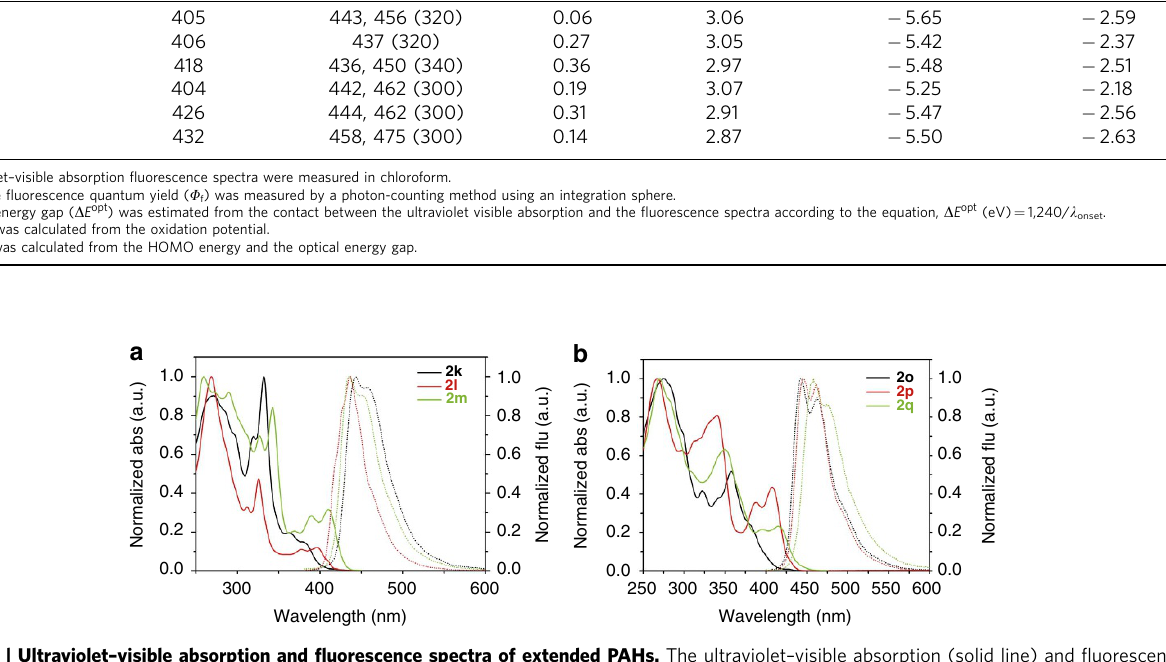
Table 2 | Optical and electrochemical properties of 2k–q. Compound